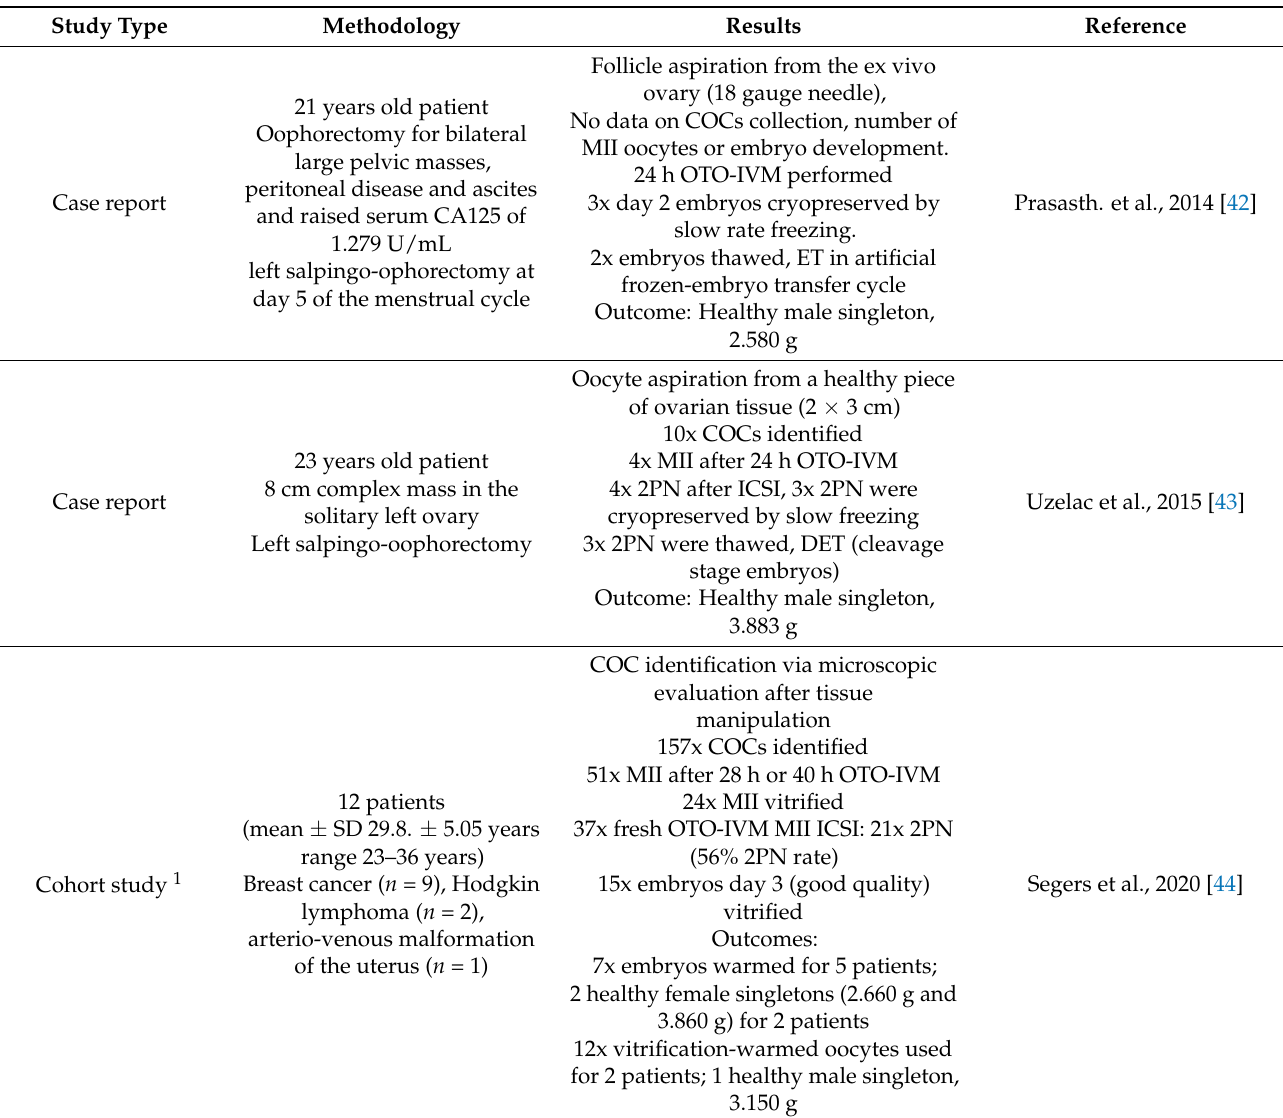
Table 2. Live births from monophasic